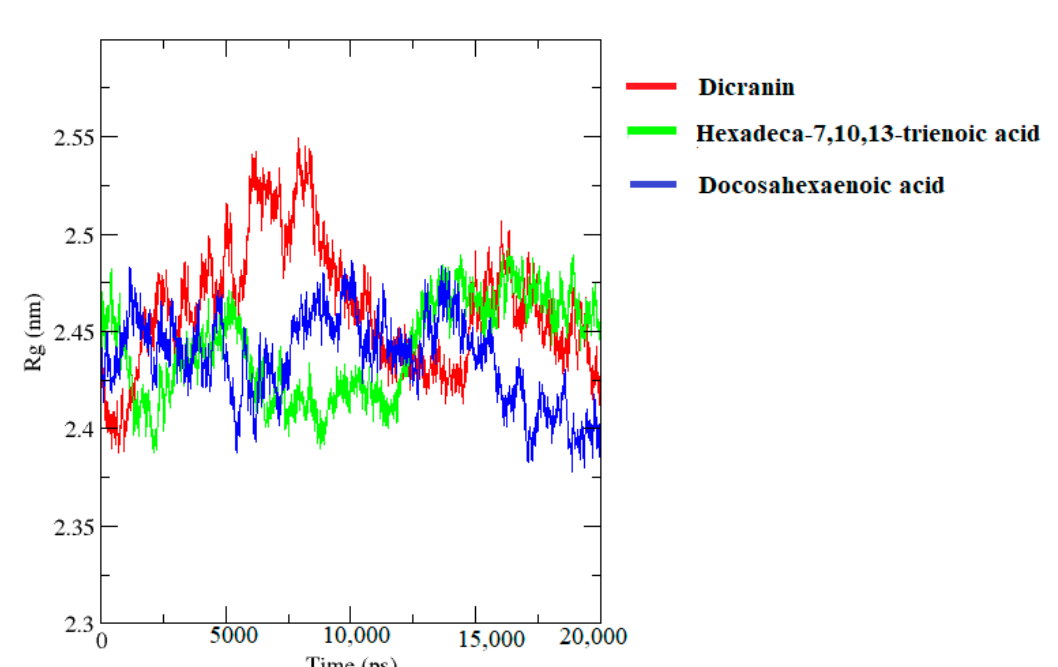
Figure 12. Radius of gyration (Rg). Radius of gyration for predicting the compactness of the protein structure of B. cinerea lipase, complexed with dicranin (red), docosahexaenoic acid (blue), and hexadeca-7,10,13-trienoic acid (green), are represented.